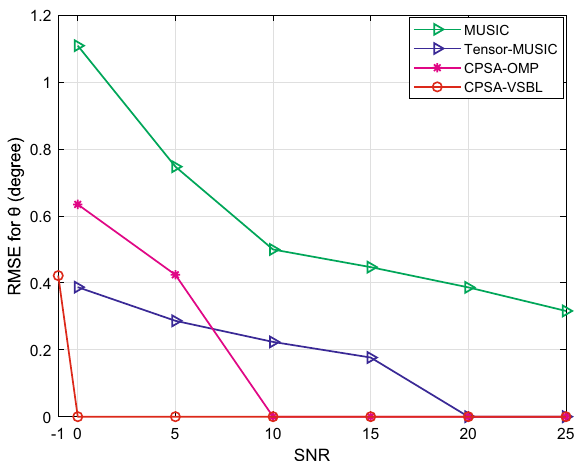
Fig. 5 The azimuth RMSE versus SNR